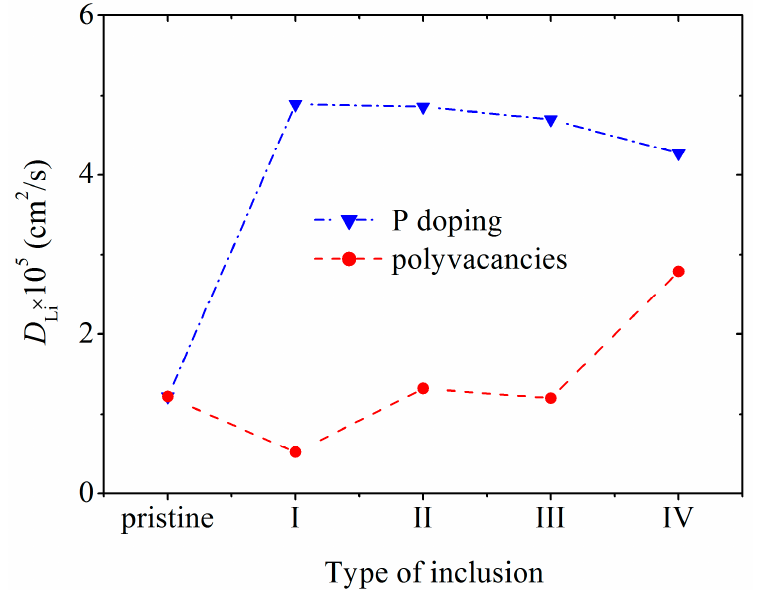
Figure 8. Diffusion coefficient of Li ions during their movement along a pristine silicene channel and a channel whose walls contain P atoms and polyvacancies: I, II, III, and IV—mono-, bi-, tri-, and hexavacancies in silicene, respectively; in all cases, the silicene channel is located on a graphite sub- strate with a nitrogen content of 5%.